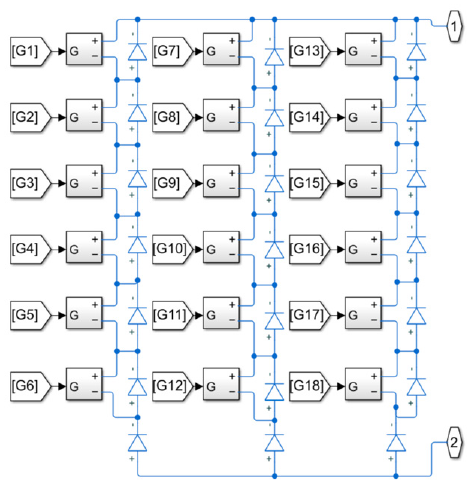
Figure 6. PV circuit configuration of a wing section.